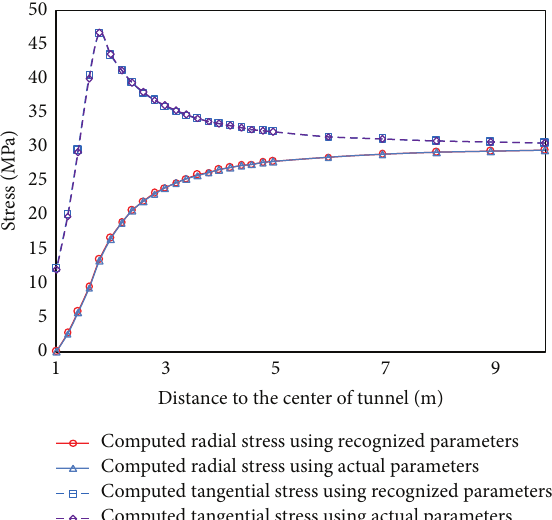
Figure 5: The comparison of stress between actual and recognized parameters.